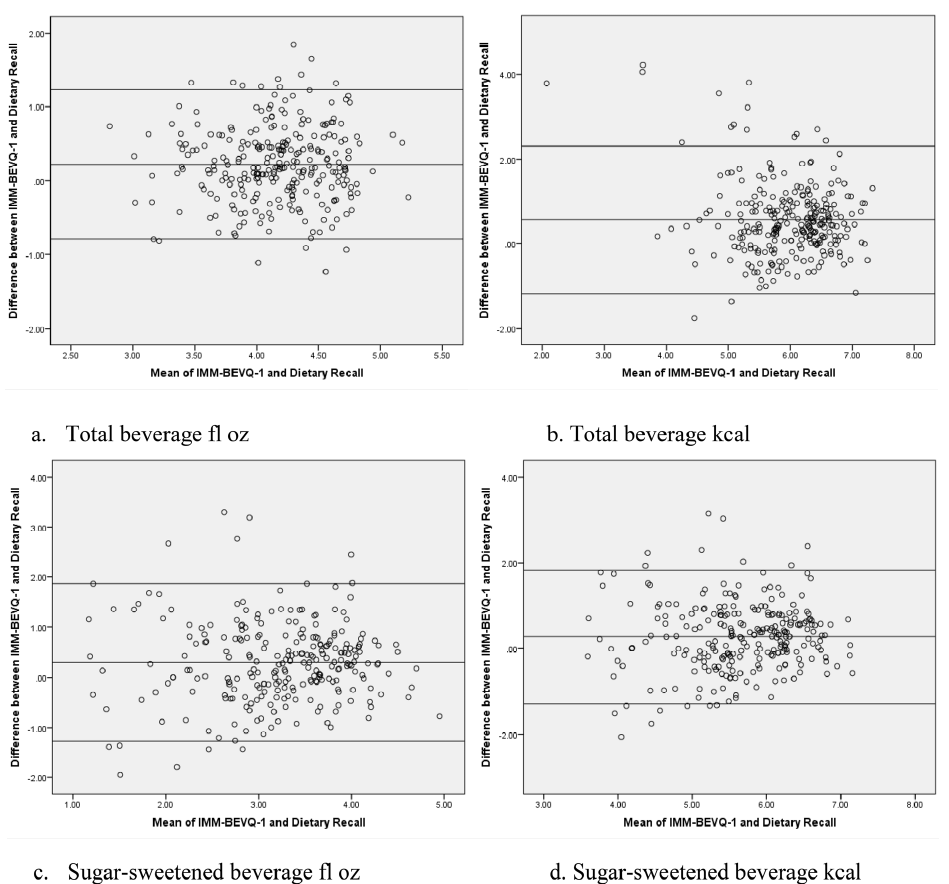
Figure 4. Bland ‐ Altman analysis of IMM ‐ BEVQ ‐ 1 and Dietary Recalls for ( a ) total beverage fl oz; ( b ) Figure 4. Bland-Altman analysis of IMM-BEVQ-1 and Dietary Recalls for ( a ) total beverage fl oz; total beverage kcal; ( c ) total sugar ‐ sweetened beverage fl oz; and ( d ) total sugar ‐ sweetened beverage ( b ) total beverage kcal; ( c ) total sugar-sweetened beverage fl oz; and ( d ) total sugar-sweetened beverage kcal. All values are log ‐ transformed. The center line represents the mean difference and the upper kcal. All values are log-transformed. The center line represents the mean difference and the upper and and lower lines indicate the mean ± 1.96 standard deviation. lower lines indicate the mean ± 1.96 standard